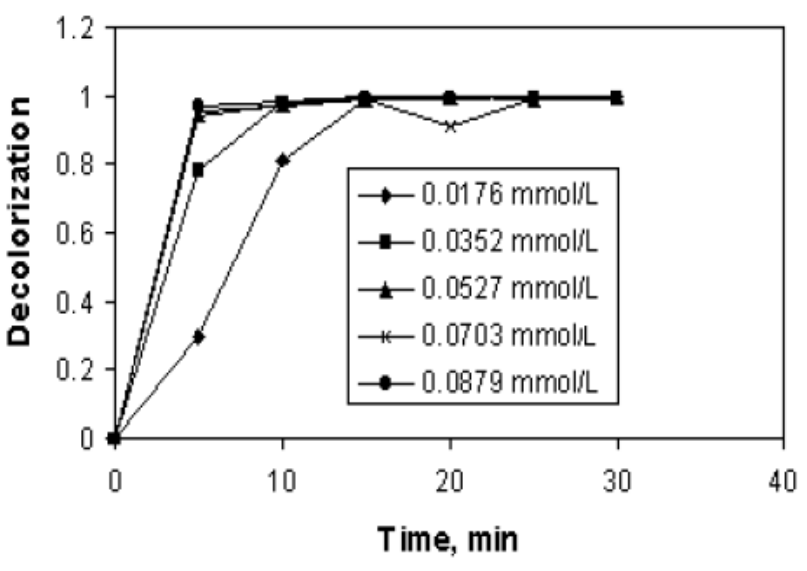
Fig. 6 The effect of ferrous ion concentration on the decolorization rate. Initial conditions: C dye =50 mg/L, pH=5.675-6.325, [H 2 O 2 ]= 17.318